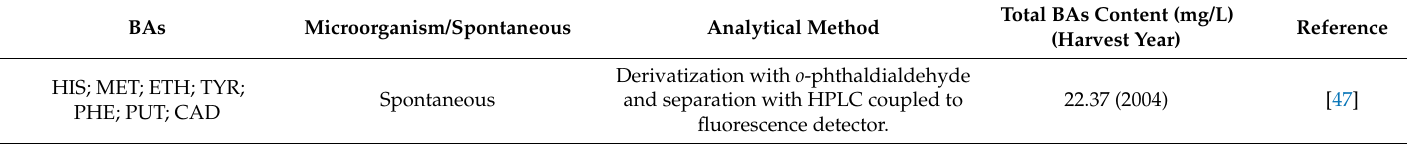
Table 1. BAs determination in wines after alcoholic